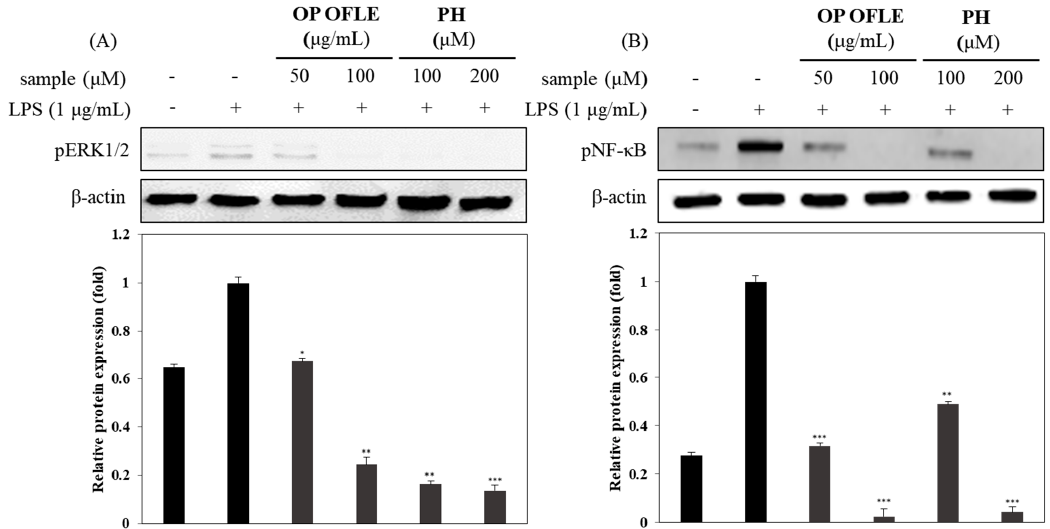
Figure 8. Effects of OP OFLE and PH on pERK1/2 activation and NF- κ B expression . Inhibition of the OP OFLE (50 and 100 μ g/mL) and PH (100 and 200 μ M) on LPS-induced pERK1/2 ( A ) and NF- κ B ( B ) proteins in RAW264.7 macrophages. Cells were pretreated with OP OFLE or PH at different concentrations for 2 h and then stimulated with LPS for 1 h. Expression of pERK1/2 and NF- κ B proteins were detected by Western blot using specific pERK1/2 and NF- κ B antibodies. β -Actin was used as a loading control. Relative density of NF- κ B compared to that of β -actin was calculated. Blots shown are representatives of three independent experiments with similar results. * p < 0.05, ** p < 0.01, *** p < 0.001 vs. LPS-stimulated group.